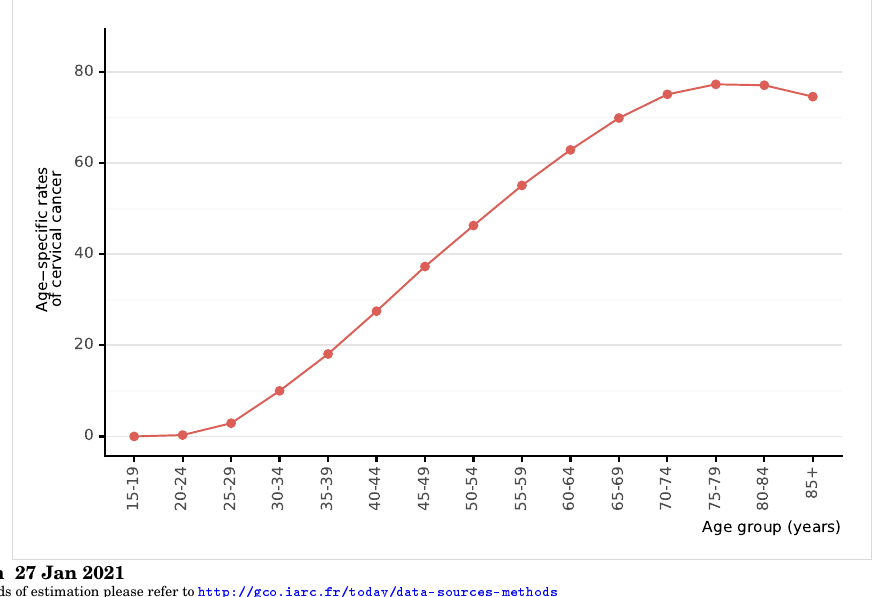
Figure 8: Age-specific incidence rates of cervical cancer in India (estimates for 2020)